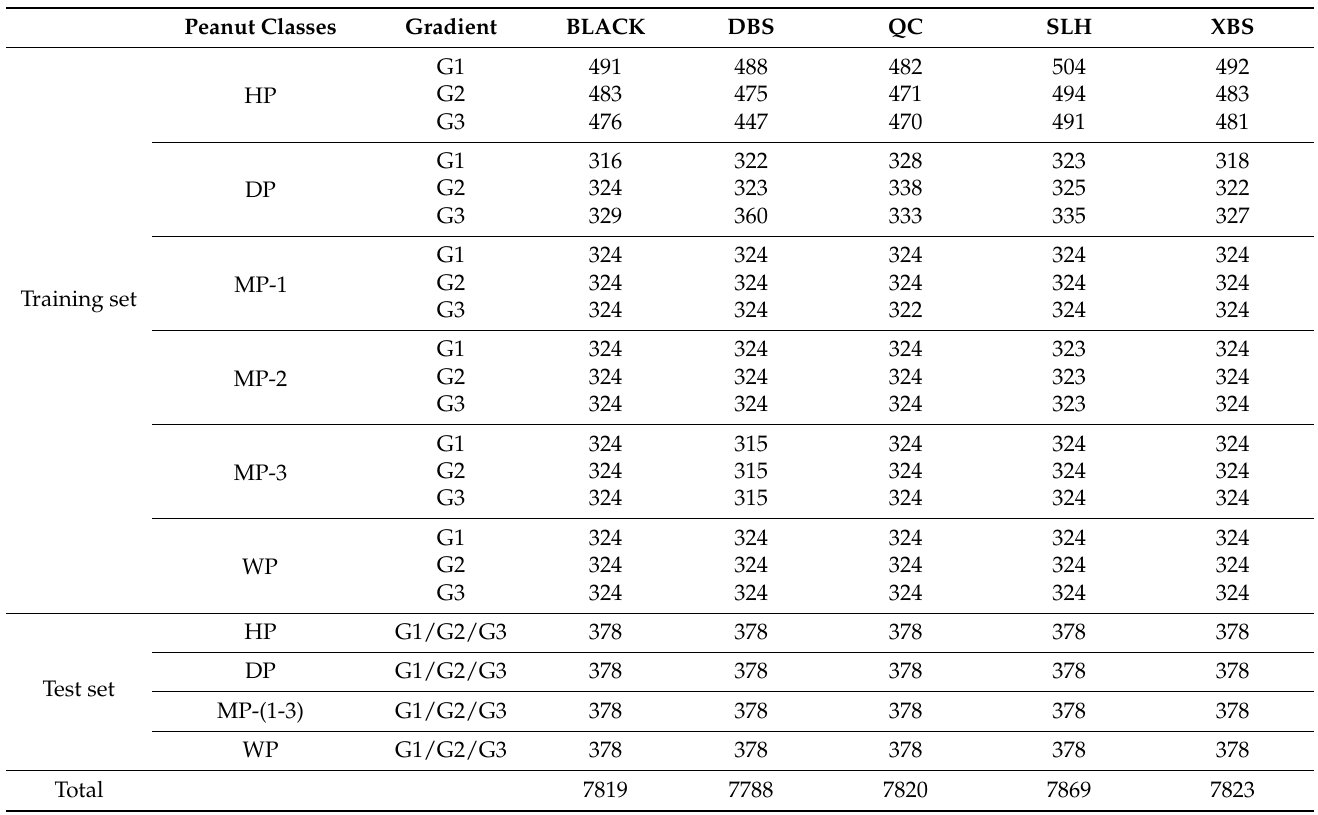
Table 1. Overview of experimental data